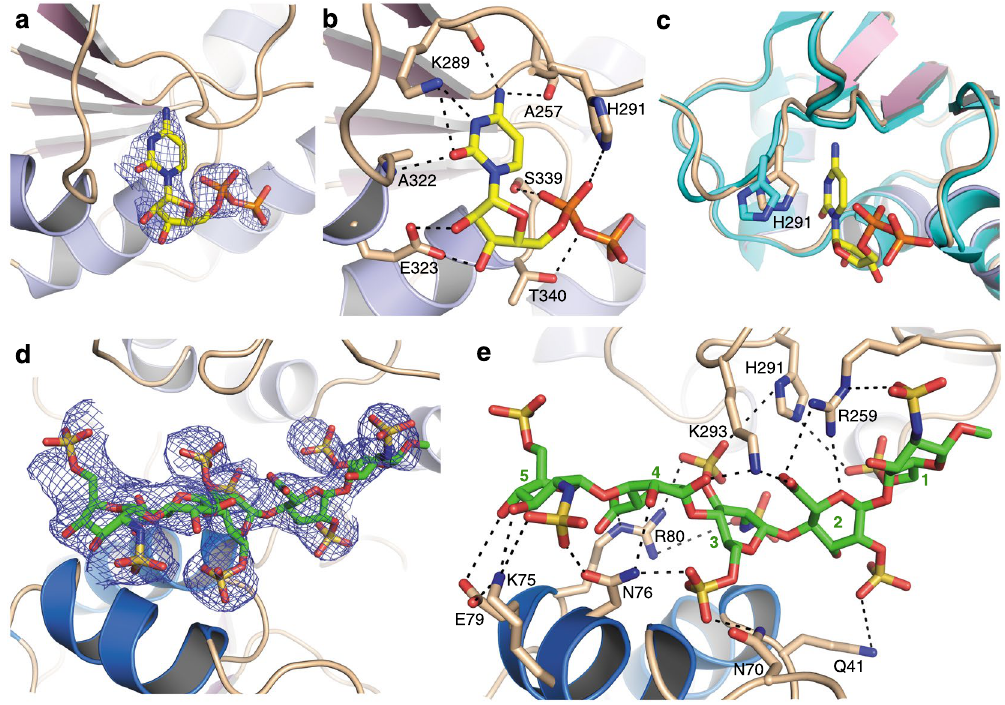
Figure 2. Structures of substrate-bound complexes of Mh PST. ( a ) Experimental Fo – Fc omit electron density map for CDP (yellow sticks) bound to Mh PST (ribbon diagram of monomer A) is shown as a blue mesh contoured at 3.0 σ . Structure factor calculation was performed prior to CDP docking. ( b ) Nucleotide donor binding site of Mh PST (monomer A) with residue side chains interacting with bound CDP (yellow sticks) shown in sticks and labelled. Potential hydrogen bonds are indicated as black dashes. ( c ) Superimposition of donor binding sites of the apo-structure (coloured in cyan) and of the CDP-bound structure (coloured in wheat, pink, and light blue). The shift of the side chain of H291 by 1.3 Å is shown. ( a – c ) The C-terminal domain is omitted for clarity. ( d ) Experimental Fo – Fc omit electron density map for fondaparinux (green sticks) bound to Mh PST (ribbon diagram of monomer A) is shown as a blue mesh contoured at 3.0 σ . Structure factor calculation was performed prior to ligand docking. ( e ) Acceptor substrate binding site of Mh PST (monomer A) with residue side chains interacting with bound fondaparinux (green sticks) shown in sticks and labelled. The five monosaccharide units of fondaparinux are labelled and potential hydrogen bonds are indicated as black dashes. ( a , d ) Electron density improved for all ligands upon